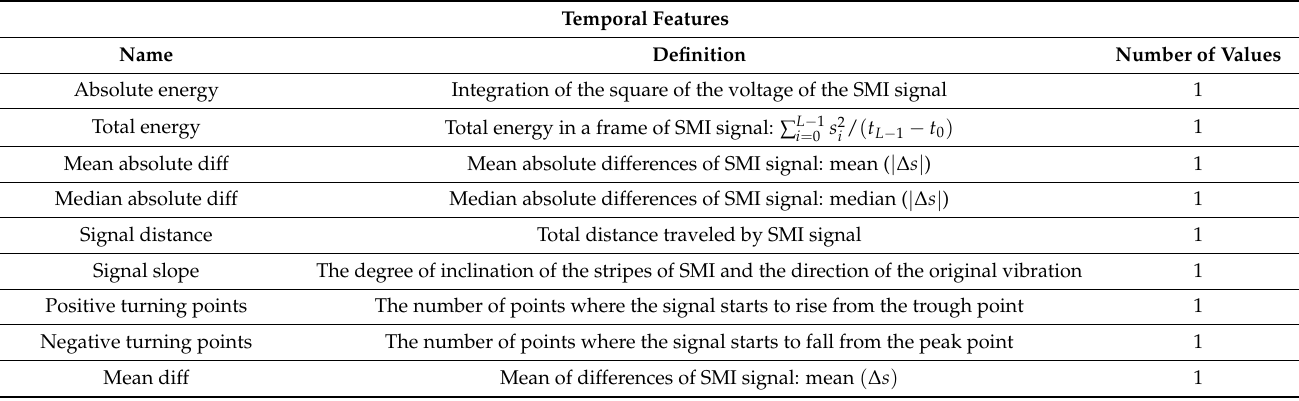
Table 1. List of 367 values of extracted